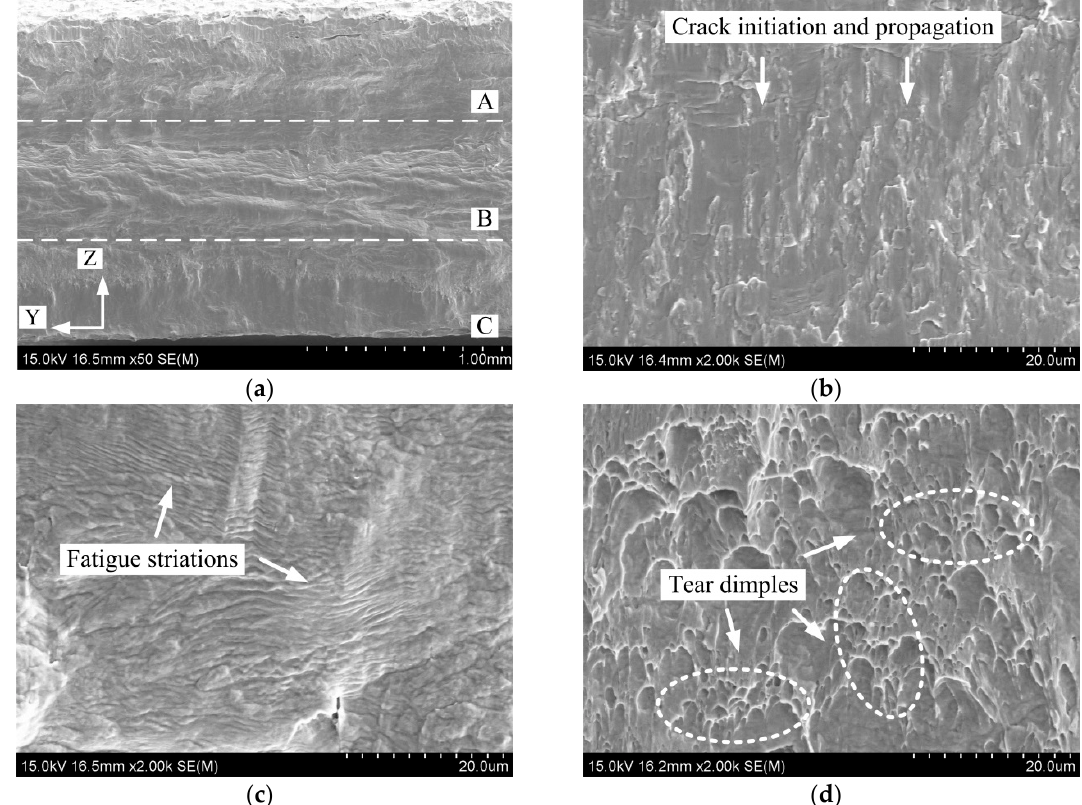
Figure 3. SEM observation of fracture surface morphology for CGP nickel sheets after pass 3 in scheme 3: ( a ) Whole section; ( b ) region A; ( c ) region B; ( d ) region C.